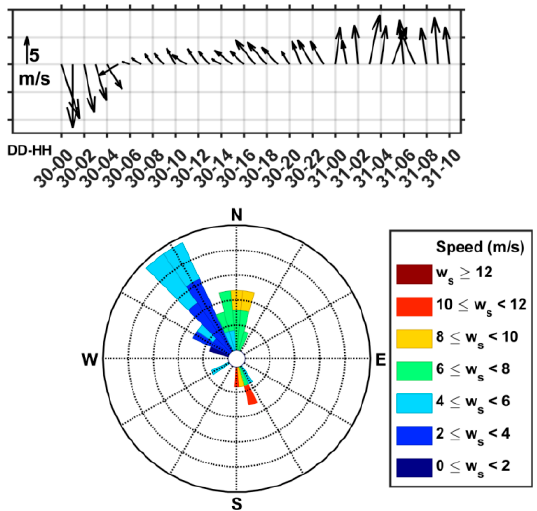
Figure 7. Hourly wind data from NOAA’s WPOW1 station starting midnight 30 December 2003. Wind direction follows the oceanographic convention, i.e., the direction is towards where the wind blows.